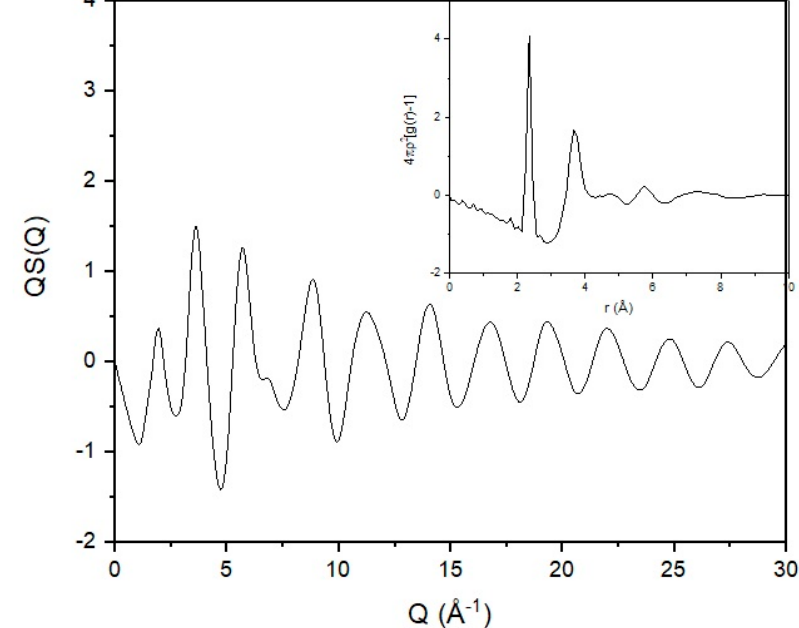
Figure 8. Total structure factor of vitreous selenium obtained from neutron scattering data. In the inset, the radial distribution function of the same scattering curve can be seen.